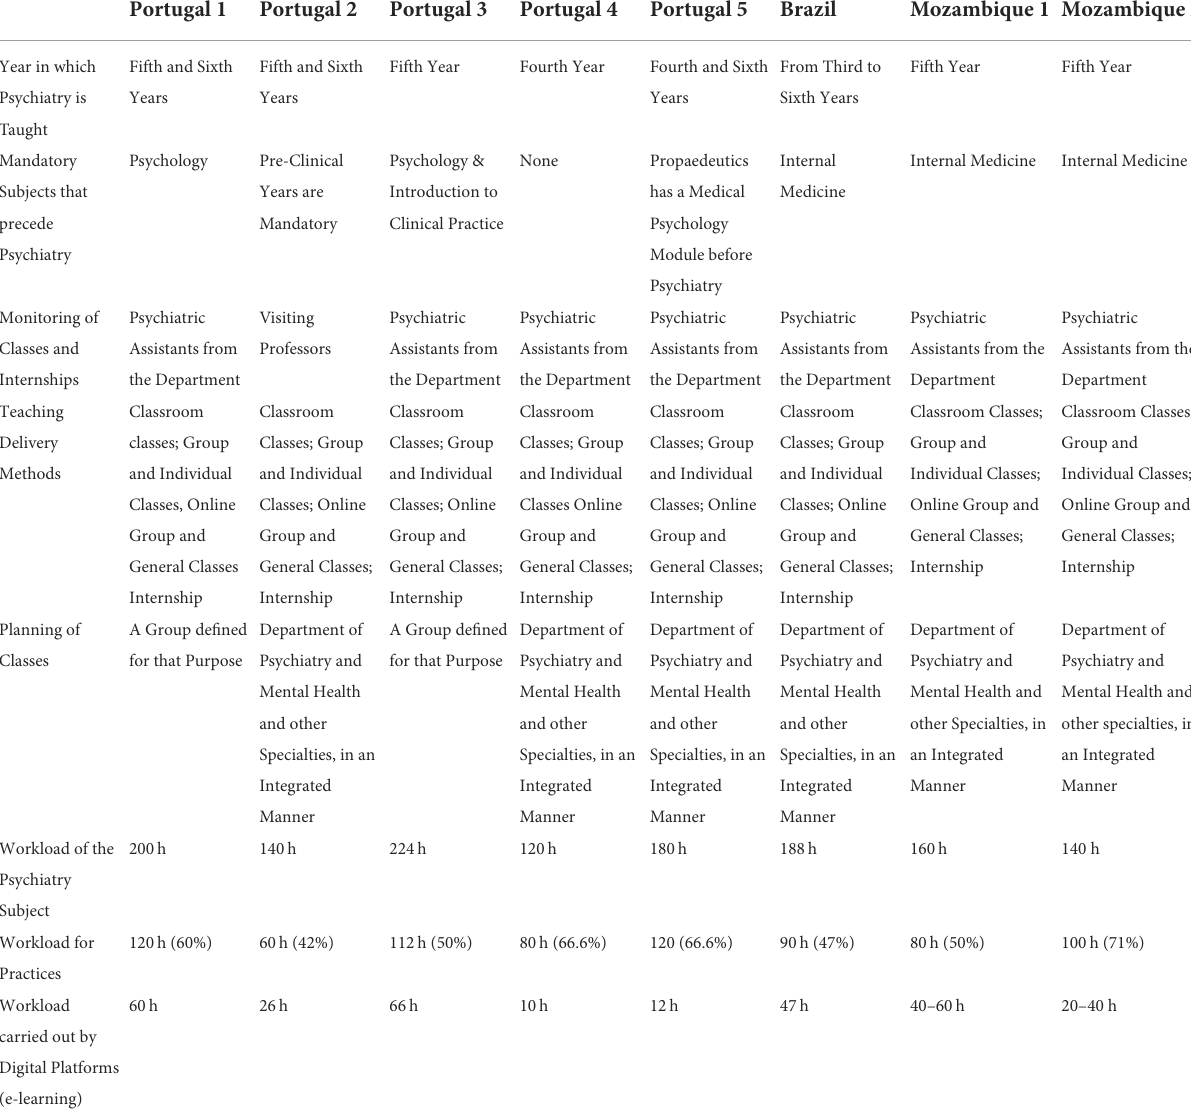
TABLE 2 Organization of the psychiatry